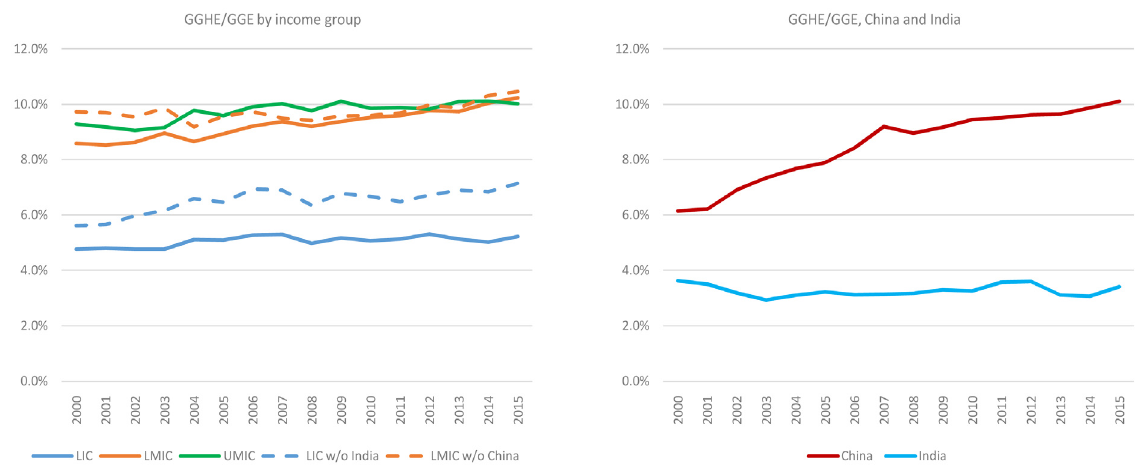
Figure 4. General government expenditure on health (GGHE)/general government expenditure (GGE) by income group, and separately for China and India, 2000 to 2015.